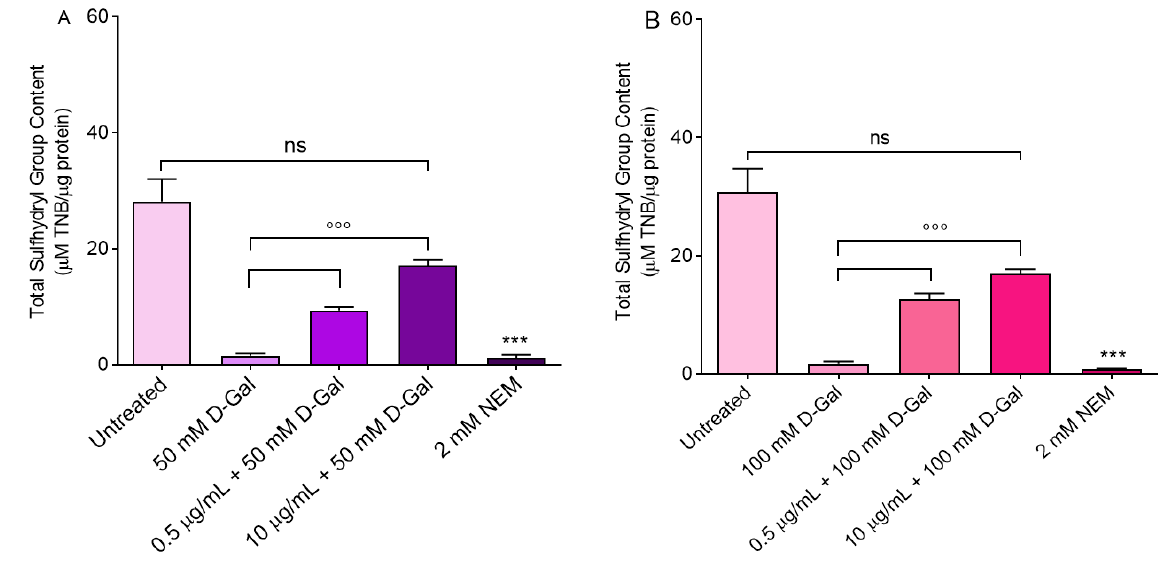
Figure 6. Measurement of total SH group content. Sulfhydryl group content (µM TNB/µg protein) in erythrocytes left untreated (control) or treated with 50 ( A ) or 100 ( B ) mM D -Gal for 24 h with or without pre-incubation for 1 h with 0.5 or 10 µg/mL freeze-dried Açaì extract, or alternatively, with 2 mM NEM (positive control). ns, not statistically significant versus control; °°°, p < 0.001 versus 50 and 100 mM D -Gal; ***, p < 0.001 versus control, one-way ANOVA followed by Bonferroni’s multiple comparison post-hoc test ( n = 10).